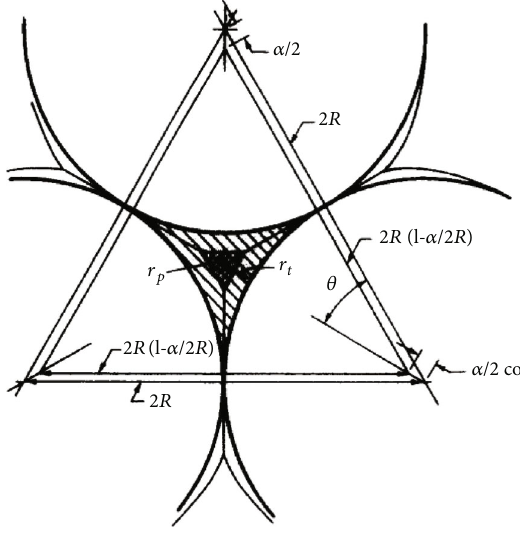
Figure 5: A schematic diagram of the deformation of rock particles under stress